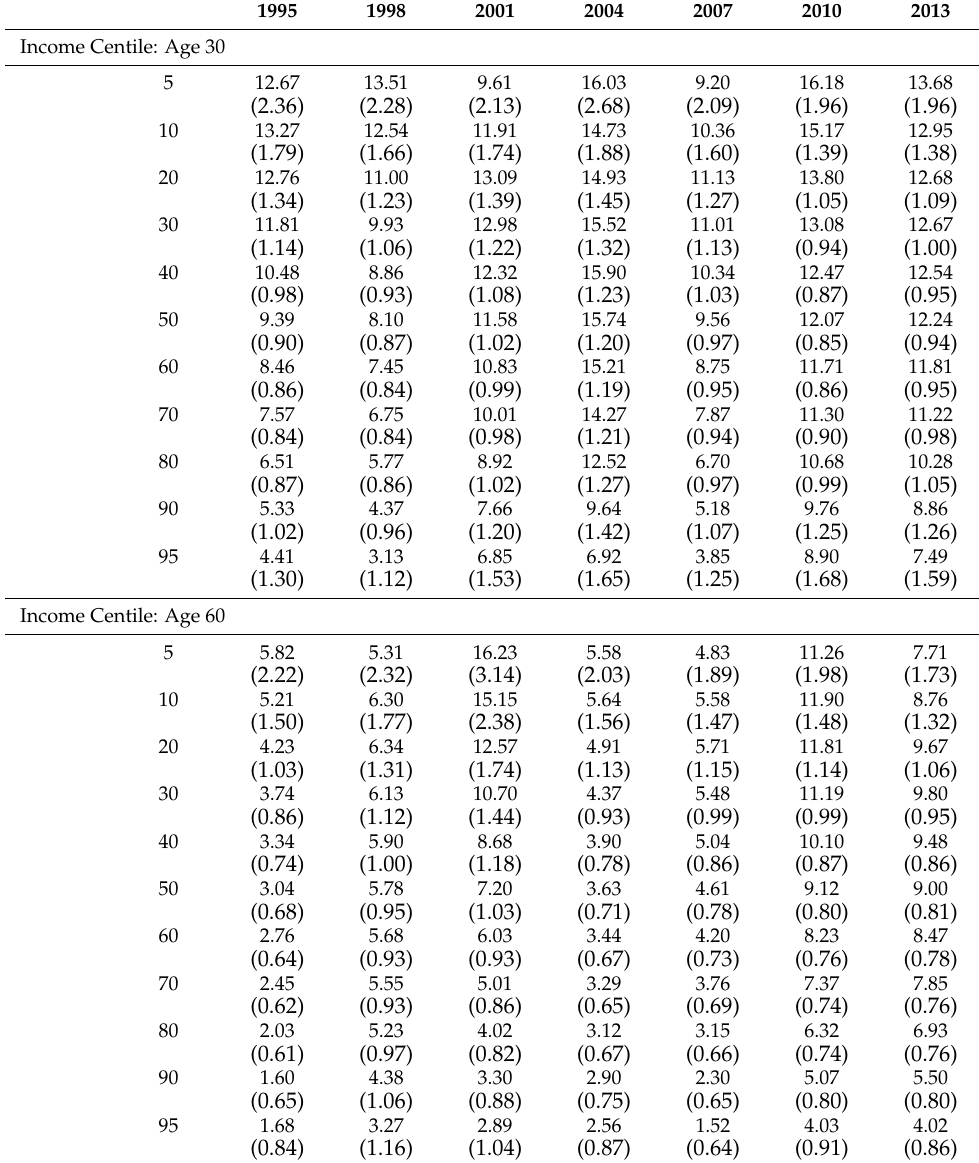
Table A5. Arrears at Different Income Centiles for Young and